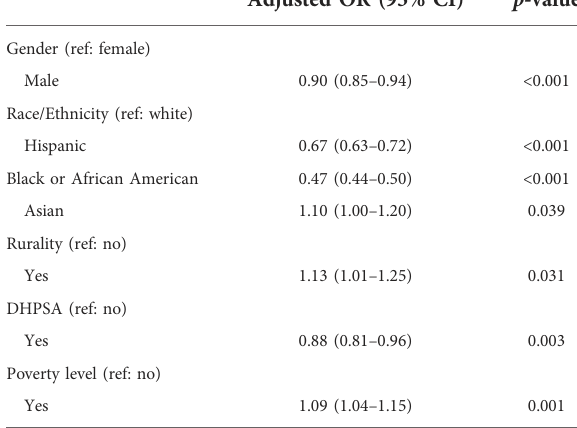
TABLE 3 Adjusted odds ratio estimates for the effect of demographic covariates on placement of permanent restoration after initial non- surgical root canal therapy (NSRCT) from multivariate logistic regression analysis.